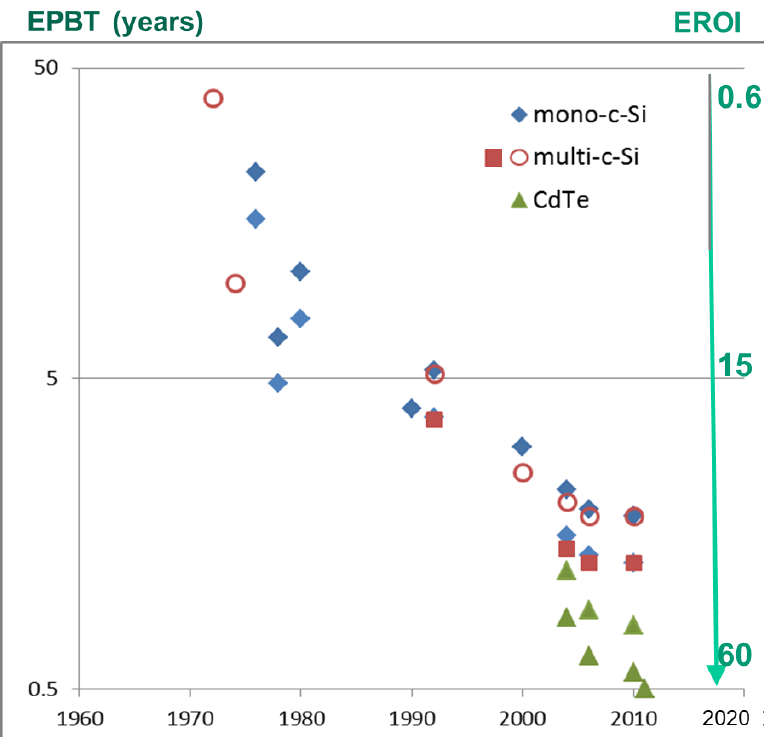
Figure 1. Historical evolution of Energy Payback Times (EPBTs) of PVs, from 50 years down to half a year and corresponding Energy Return to Energy Investment (EROI); published estimates corresponding to insolation of 1700 and 2300 kWh/m 2 /year—updated from Fthenakis and Lynn [57].